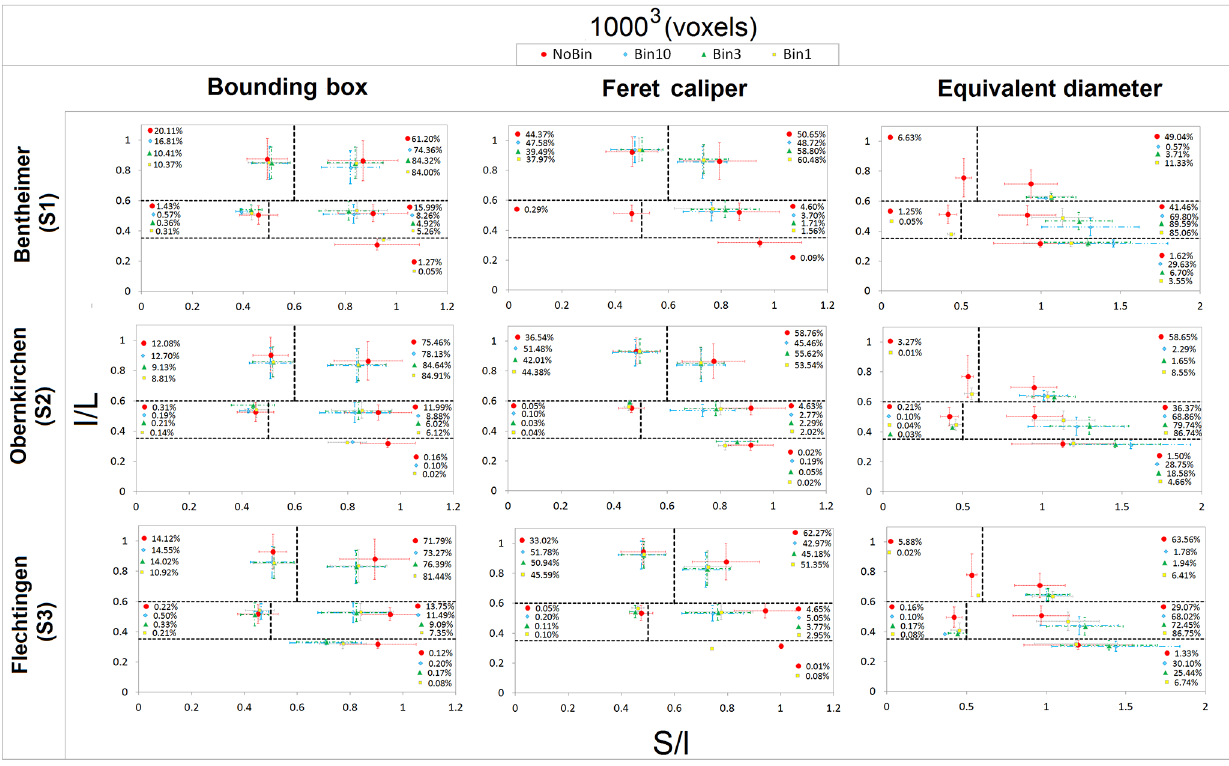
Figure 11. Pore shape quantification of samples S 1 , S 2 , and S 3 (1000 3 voxels) for the BB, FC, and EqD descriptors based on the proposed Zingg classification